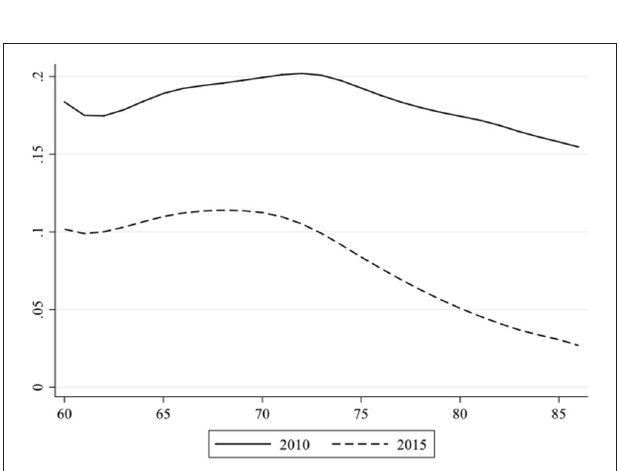
FIGURE 2 | Coefficients of housing condition on self-rated health at every age by survey year.